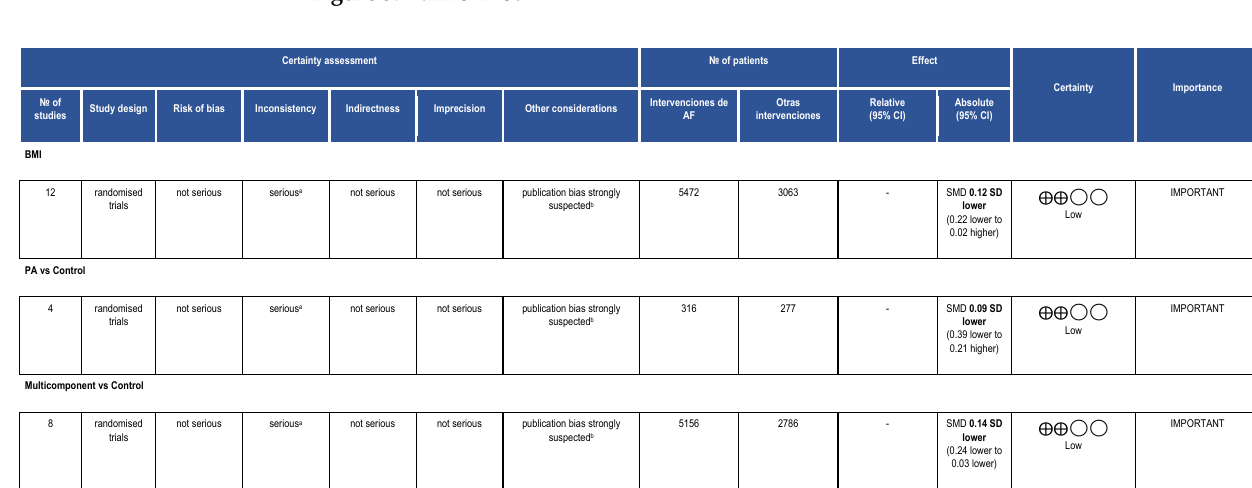
Figure 5. Funnel Plot.